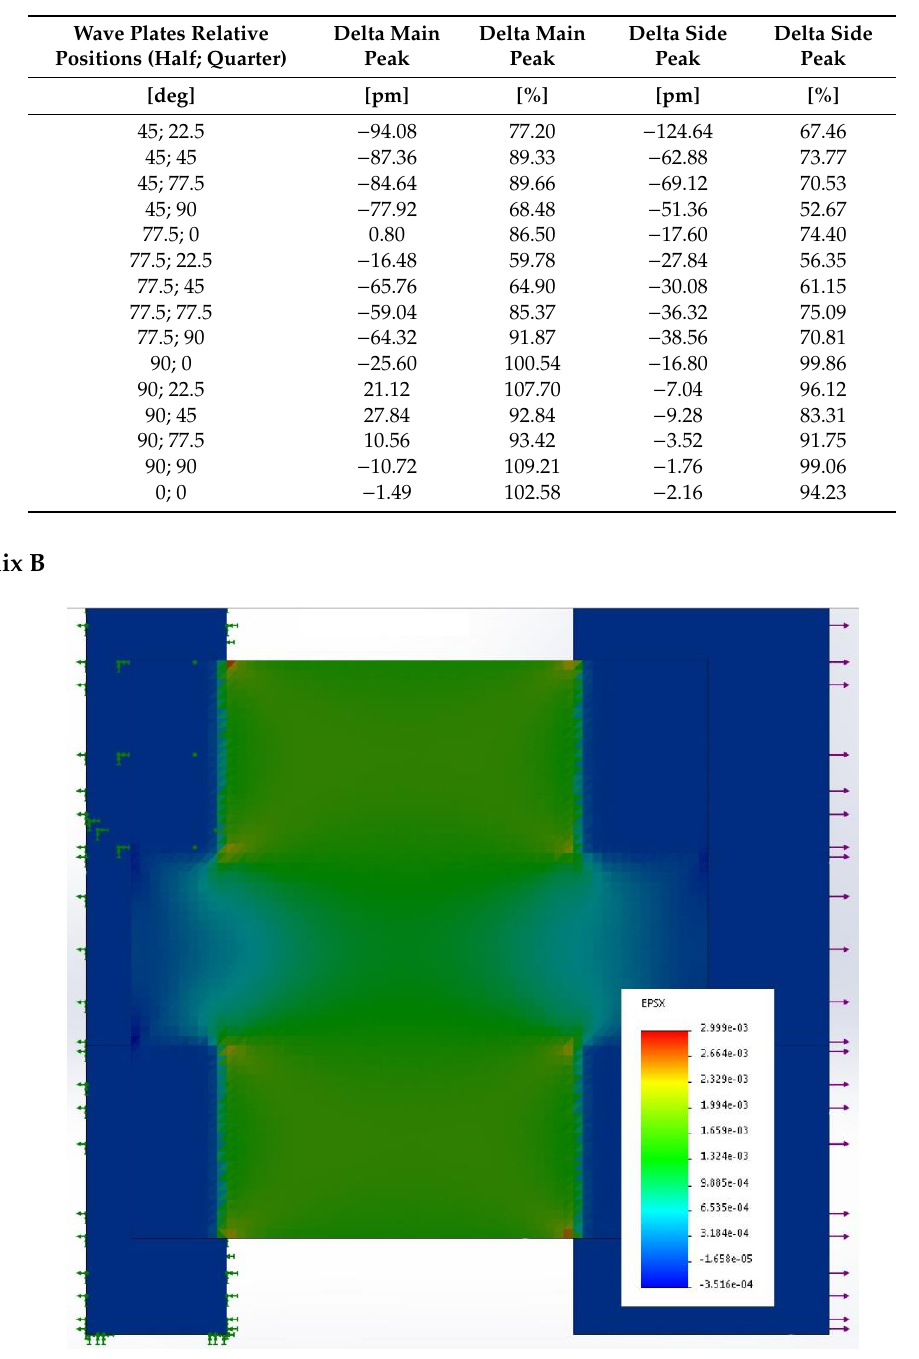
Figure A1. Top view of the result of a static strain analysis for the polymeric sensor element with SolidWorks 2018. In the simulation, the left stage is set to be fixed (indicated by the green arrows), while the right is defined as a slide bearing. A force of 28 N is applied to the right stage (purple arrows), thus resulting in a total lengthening of 30 µm between the two stages. The result shows the strain in the sensor plane in the direction of the force. Because the substrate is fixed at its outer edges to the stages by means of adhesive, the applied force results in a lower strain in the sensor area, as could be expected from the total lengthening under the assumption of uniform strain distribution. Qualitatively, the simulation result shows a strain approximately 2–3 times lower in the sensor area (color blue to green) compared to the values in the area between two fixed points (green).